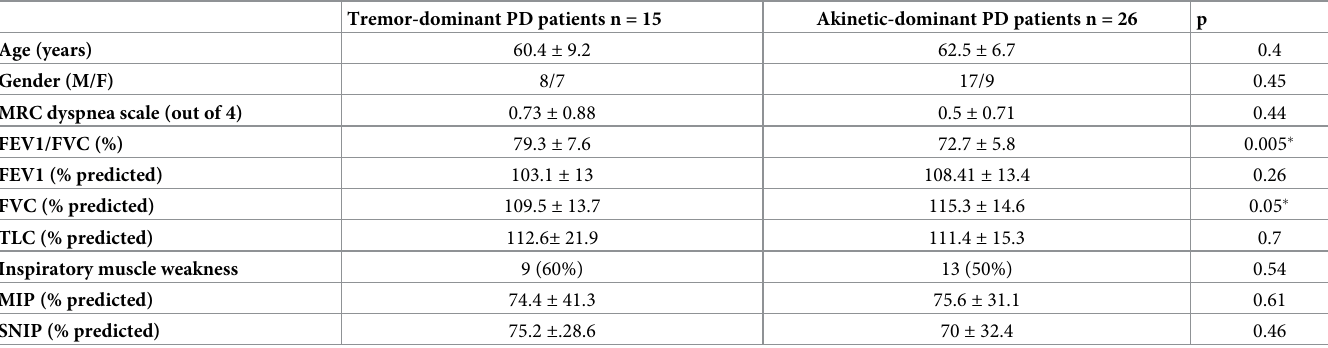
Table 3. A comparison between tremor and akinetic dominant PD